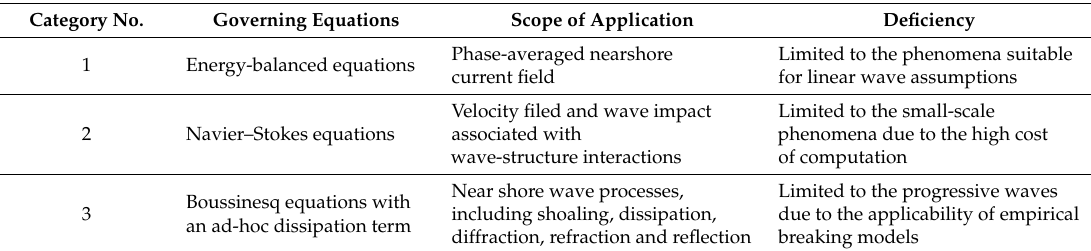
Table 2. Three categories of existing models for predictions of nearshore wave hydrodynamics. Category